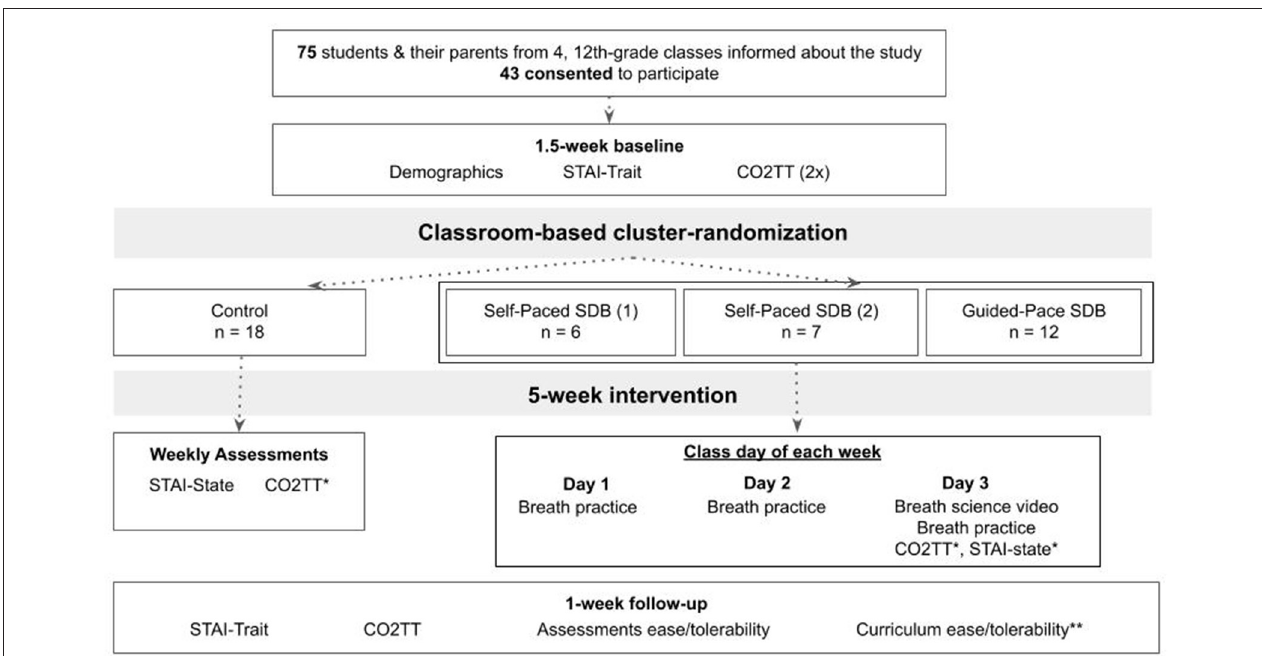
FIGURE 1 | Participant flow through study recruitment, procedures, data collection, and intervention. CO 2 TT, carbon dioxide tolerance test; SDB, slow diaphragmatic breathing; STAI, State-Trait Anxiety Inventory. *For the control class, CO 2 TT was done each week once before and once after STAI-State; for the breathing classes, CO 2 TT and STAI-State were both done each week once before and once after that day’s breathing practices and the breath science video. **Only for participants in the breathing